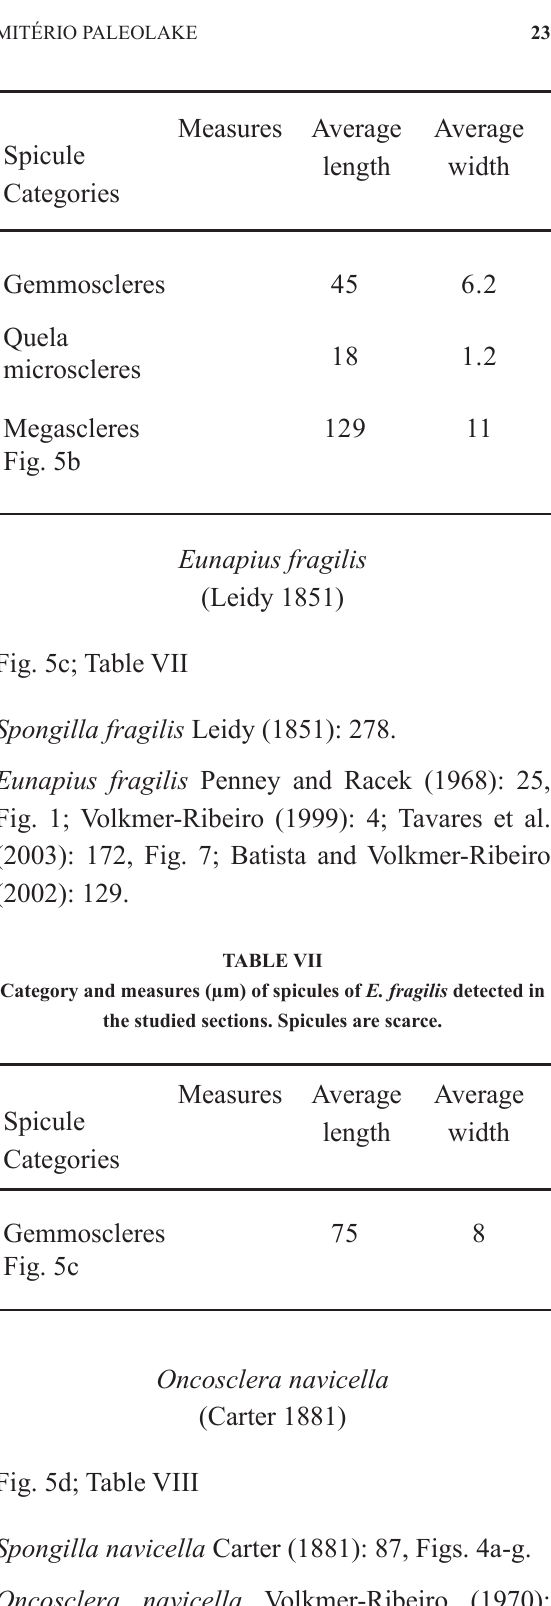
Category and measures (µm) of spicules of C. seckti detected in the studied sections. Spicules are